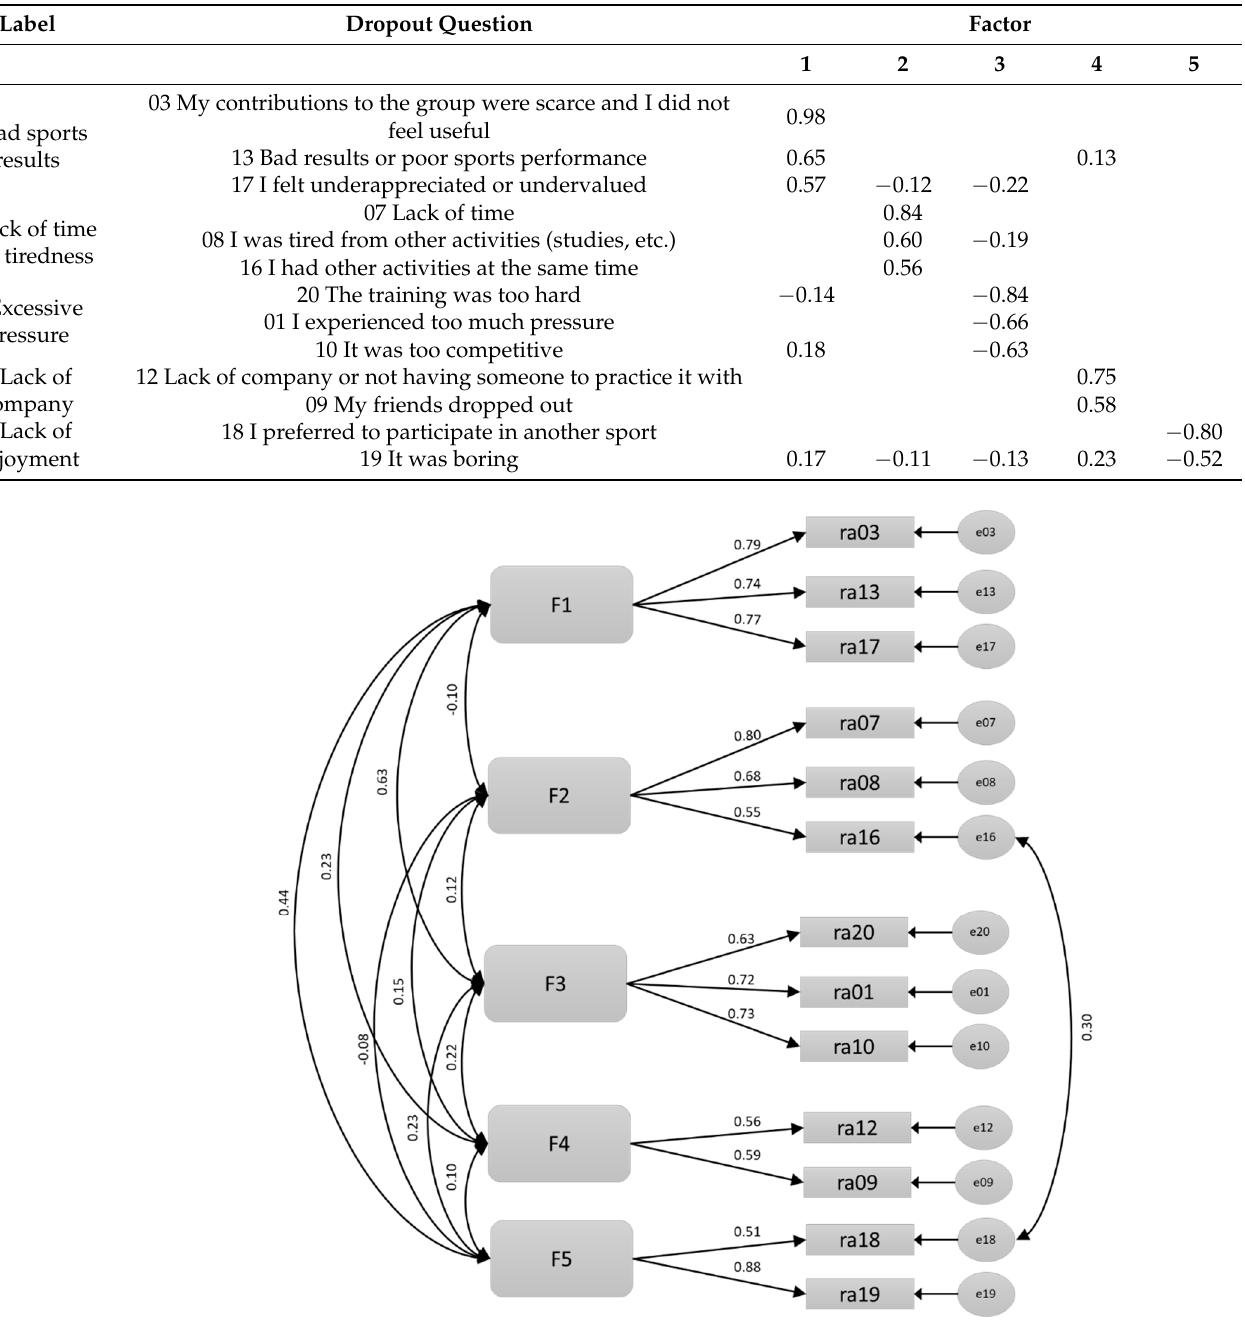
Table 3. Exploratory factor analysis of dropout reasons questionnaire.